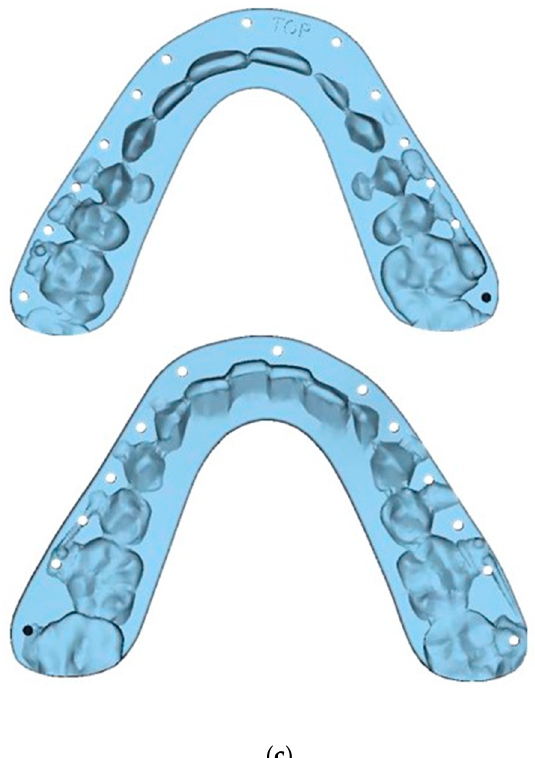
Figure 5. Guide Design: Intermediate Splint (Mandible surgery first)—Mandible has been auto- rotated slightly to allow for the design of the intermediate splint: ( a ) Frontal view; ( b ) Left side view; ( c ) Splints.